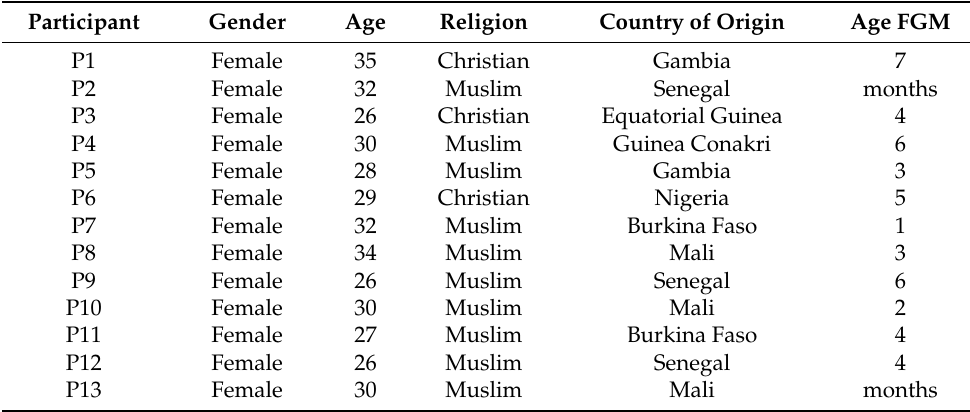
Table 1. Sociodemographic characteristics of the